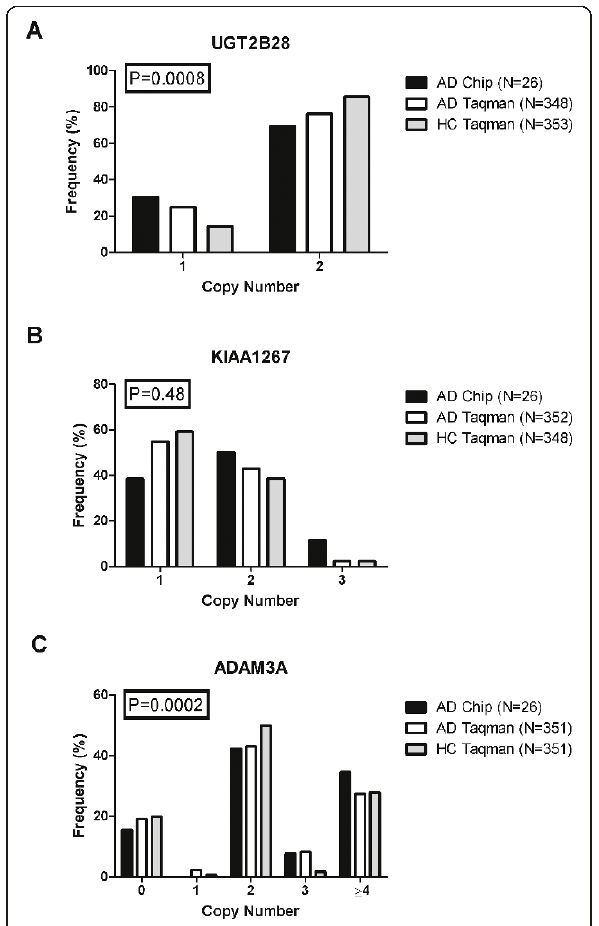
Figure 2 Copy number variations in genes associated with AD by the Affy 6.0 chip . Copy number frequencies in Addison patients and controls for the three genes associated with AD by the Affy 6.0 chip (AD chip) and validated by duplex RT-qPCR. UGT2B28 (a), KIAA1267 (b), and ADAM3A (c). P-values for differences of copy number variation between Addison patients (AD Taqman) and healthy controls (HC Taqman) were calculated by Fishers ’ s Exact